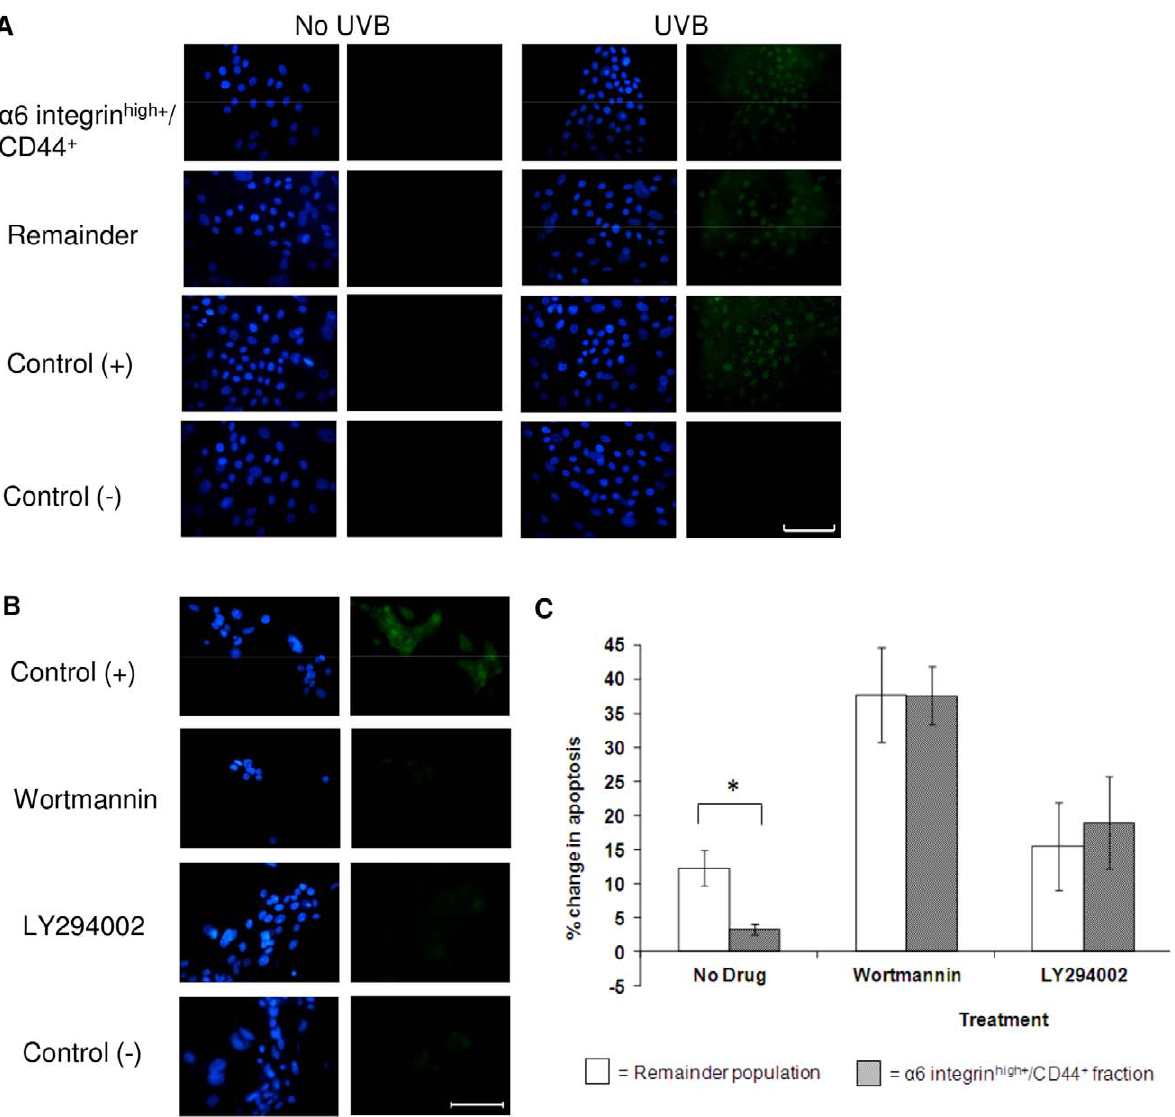
Figure 5. Apoptosis following inhibition of the PI-3 Kinase Pathway. (A) Immunofluorescence detection of phosphorylated Akt (pAkt Ser473 ) in FACS-separated a 6 integrin high + /CD44 + and remainder keratinocytes treated with 30 mJ/cm 2 UVB irradiation. The positive control is the unfractionated total keratinocyte population probed with both the primary and secondary antibodies and the negative control prepared with the secondary antibody only. Images are representative of n=3 and cell nuclei were detected with DAPI (blue). The scale bar is equal to 100 m m. (B) Sub- confluent primary keratinocytes probed for detection of phosphorylated Akt (pAkt Ser473 ) following treatment with 1 m M wortmannin or 50 m M LY294002 prior to UVB irradiation (30 mJ/cm 2 ). Control cells were treated with the vehicle-only and negative controls prepared by omission of the primary antibody. Cell nuclei were detected using DAPI (blue) and images are representative of n=3. The scale bar is equal to 100 m m. (C) Primary keratinocytes treated with 1 m M Wortmannin, 50 m M LY294002 for 2 hr, or no drug (vehicle-only control), were analysed for positive TUNEL expression 24 hr post-irradiation with UVB (30 mJ/cm 2 ). The graph shows TUNEL + cells in the a 6 integrin high + /CD44 + and remainder populations plotted as a change in percentage from control level (0 mJ/cm 2 , , 3.5% apoptosis). Data represents the mean 6 SEM where n=4. Statistical significance was determined using the paired Student’s t-test, *P , 0.05.